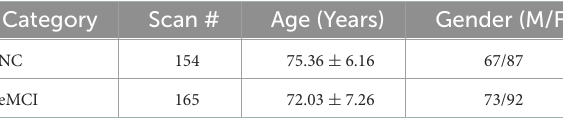
TABLE 1 Demographic information of the studied subjects.